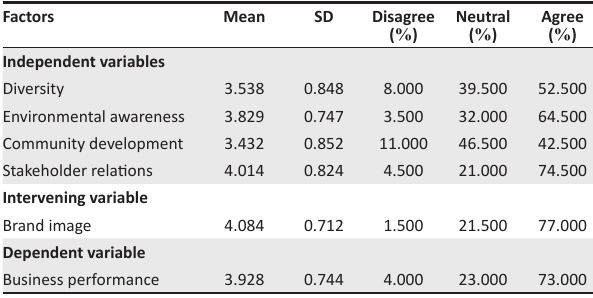
TABLE 4: Descriptive statistics on variables ( n =